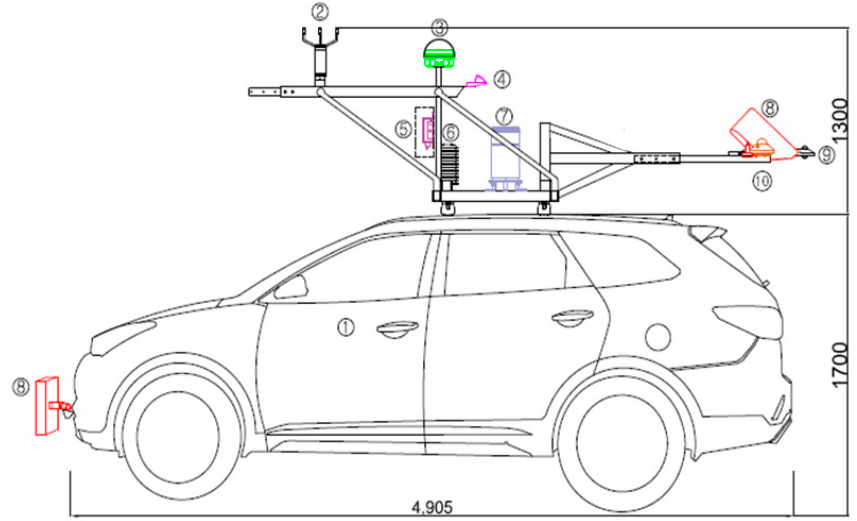
Figure 3. Detailed schematic diagram of the Mobile Observation Vehicle (MOVE) equipped with road weather and meteorological sensors (obtained from Kim et al., 2019 [9]).